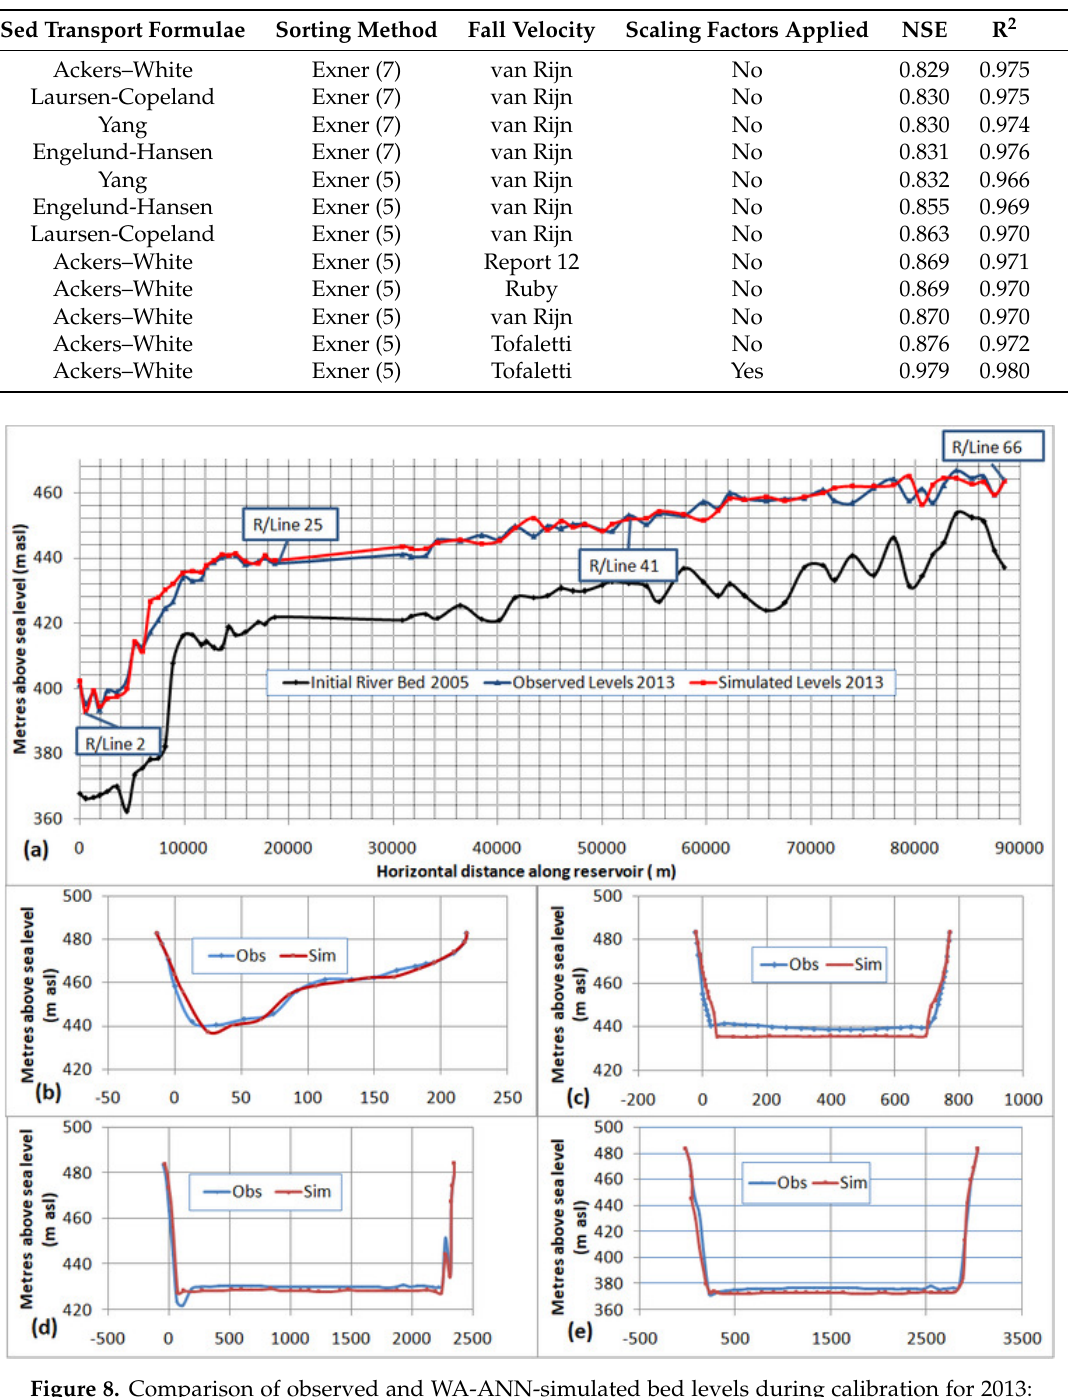
Table 6. Statistical performance of HEC-RAS with WA-ANN sediment series by the input of different transport formulae and varying parameters.